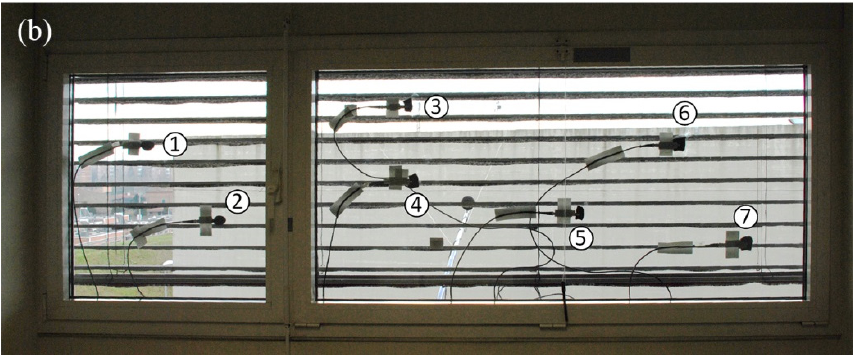
Figure 5. Microphone positions over the external side of the glazed surfaces on the ground floor ( a ) and third floor ( b ).